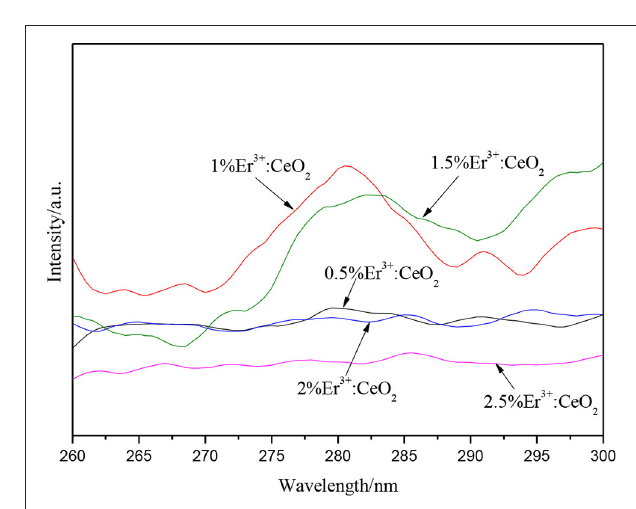
FIGURE 2 | Raman patterns of CeO 2 /ATP and Er 3 + :CeO 2 /ATP.